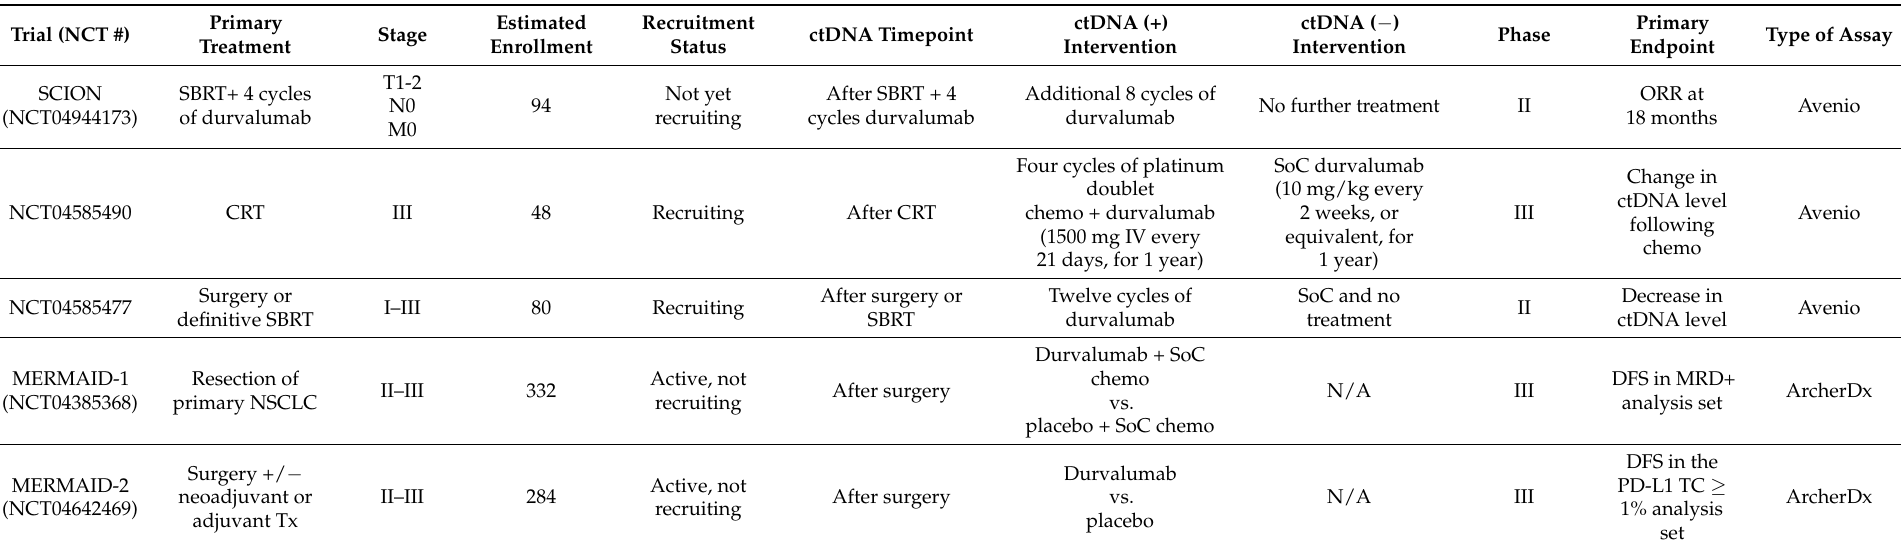
Table 2. Ongoing clinical trials actively investigating the role of ctDNA in personalized treatment in patients with